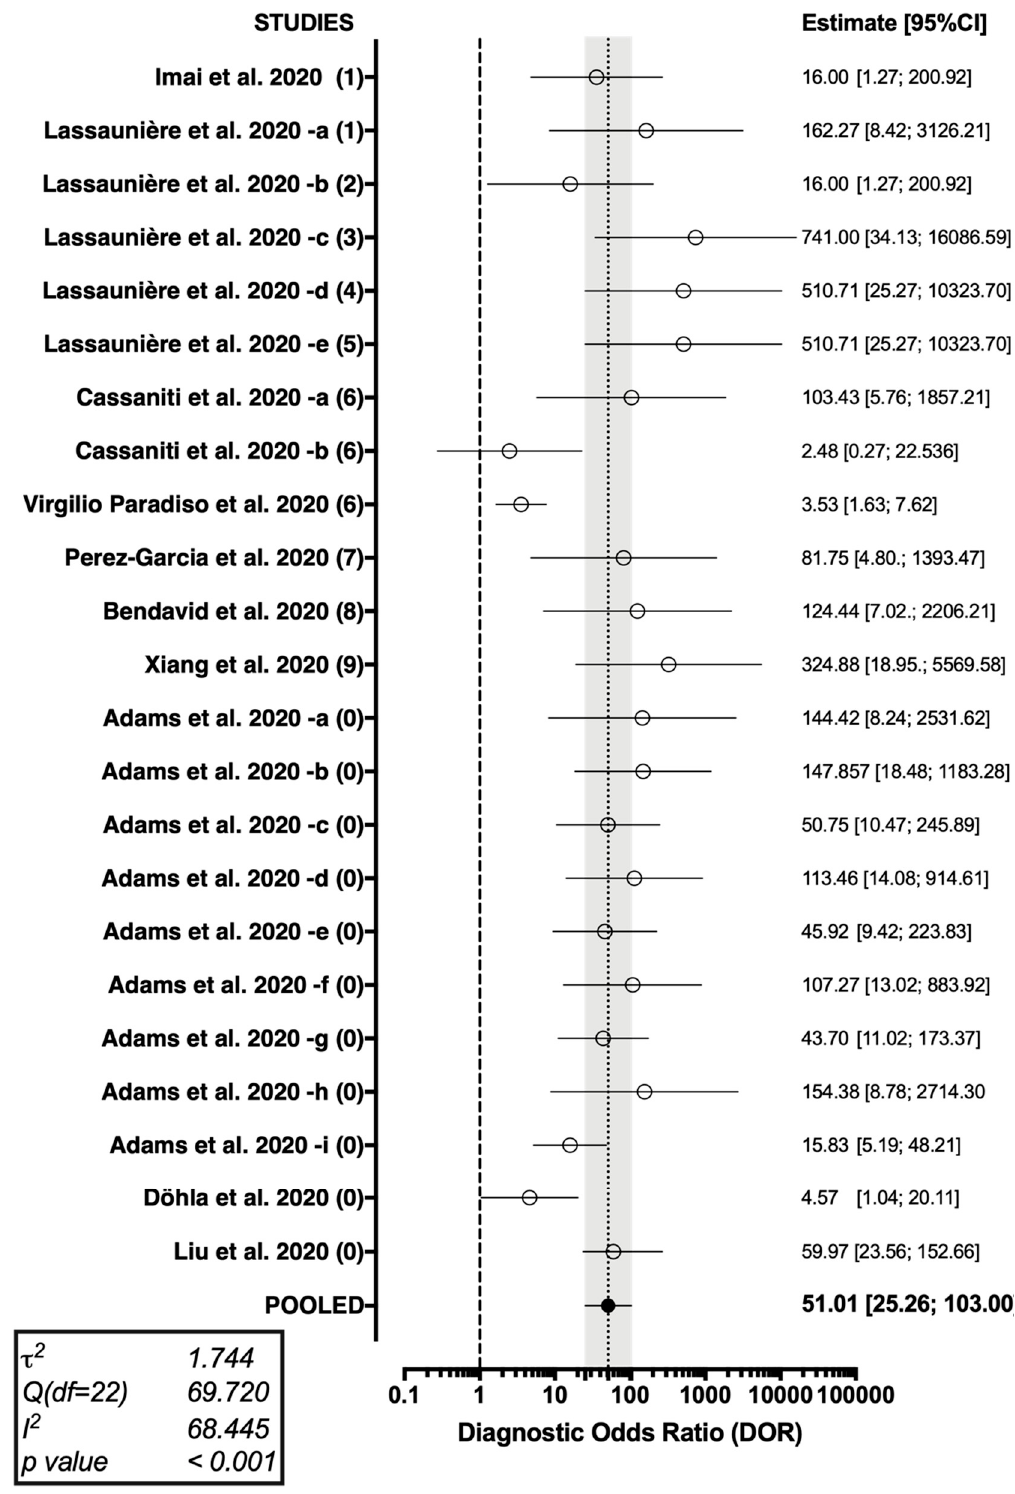
Figure 4. Forest plot representing the pooled diagnostic odds ratio of the studies on Point-of-Care COVID-19 diagnostics. A substantial heterogeneity in reported studies was identified (I 2 68.45%, Cochran’s Q: 69.720 (22 df, p < 0.001)).